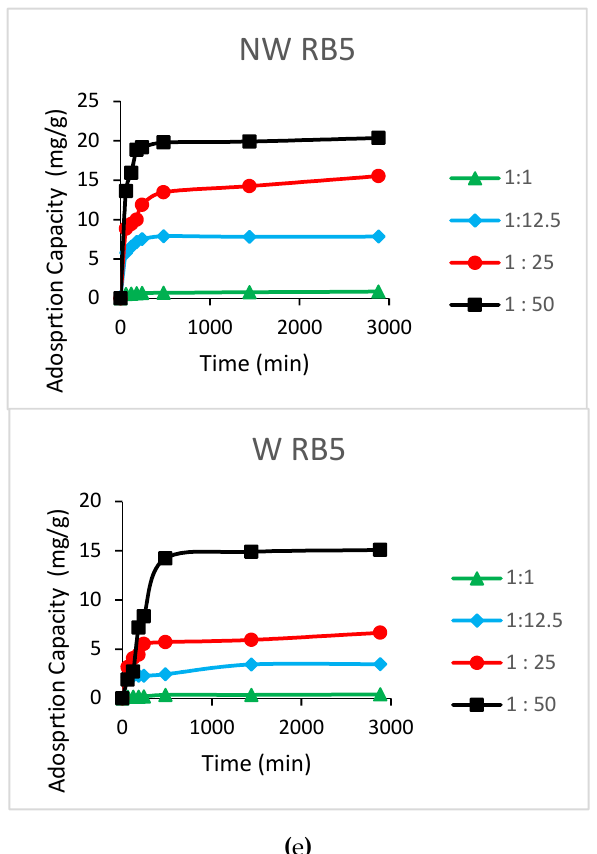
Figure 2. Effect of ratios on adsorption capacity by not washed (NW) and washed (W) digestate adsorbents towards various dyes removal. Ratios: (W adsorbents (g): C dyes (mg/L)). ( a ) Methylene Blue (MB); ( b ) Direct yellow 27 (DY27); ( c ) Acid Red 66 (AR66); ( d ) Reactive Violet 5 (RV5); ( e ) Reactive Black 5 (RB5).